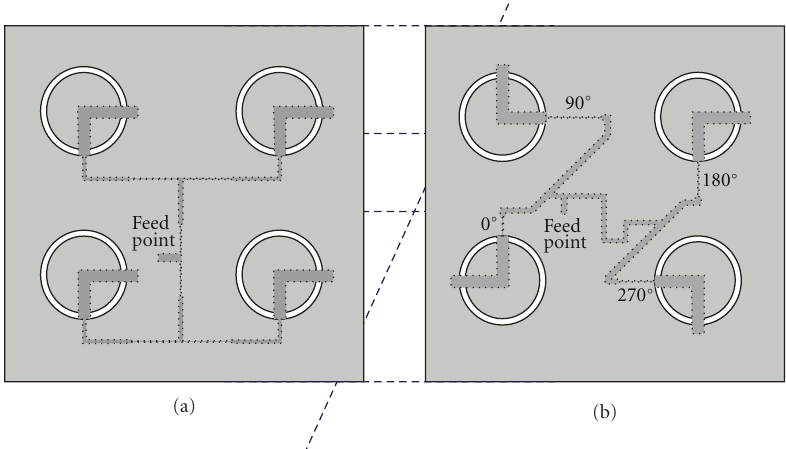
Figure 3: Structure of the reference antennas. (a) Corporate feed network, Array B. (b) Sequential rotation feed networks, Array